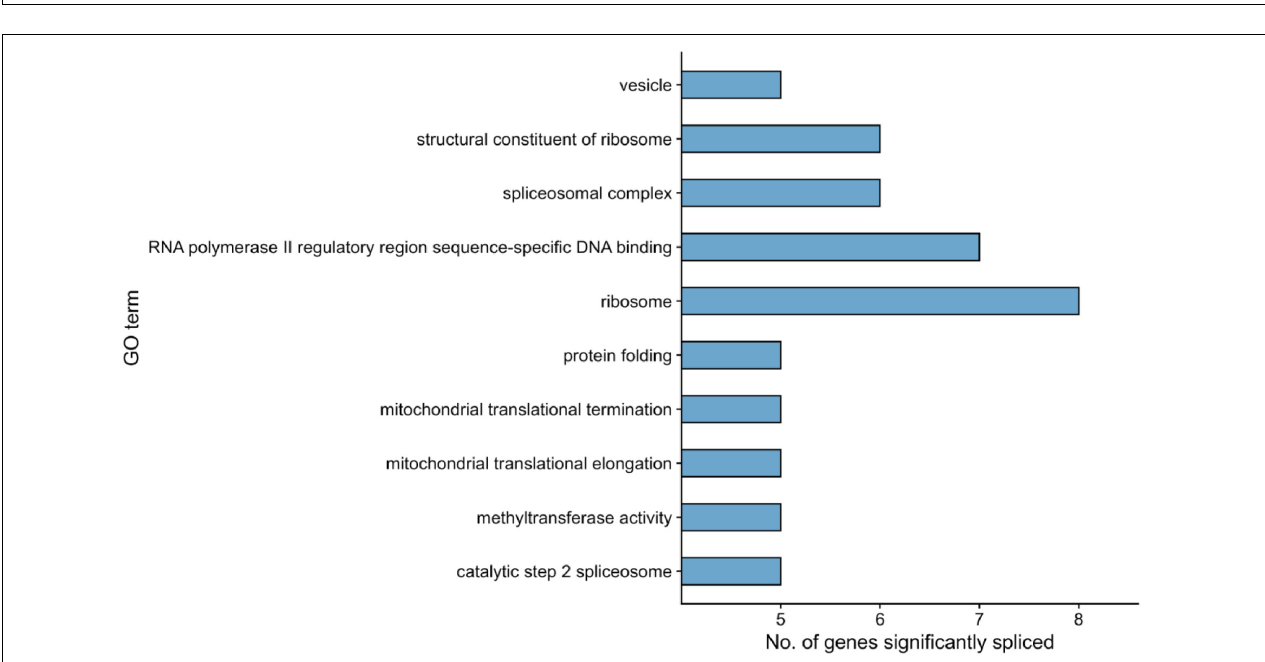
FIGURE 3 | Summary of alternatively spliced events ( p value < 0.05) in the RPE contrast. Only events unique to the Control-RPE vs. Patient-RPE contrast are shown. The proportion of events for which inclusion is favored in each clinical condition is indicated by the bar area. The number of events for each category is shown in the label above the bar. Event types: A3, Alternative 3 (cid:48) site; A5, Alternative 5 (cid:48) site; AF, Alternative First exon; AL, Alternative Last exon; MX, Mutually Exclusive Exons; RI, Retained Intron; SE, Skipped Exon.